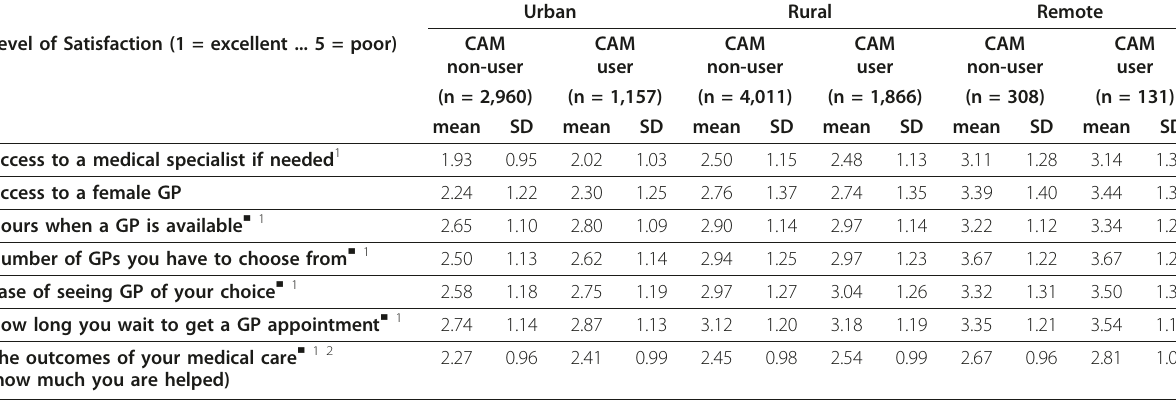
Table 2 Rating of conventional health care providers by CAM user status (consulted with a CAM practitioner or not) Urban Rural Remote Level of Satisfaction (1 = excellent ... 5 =